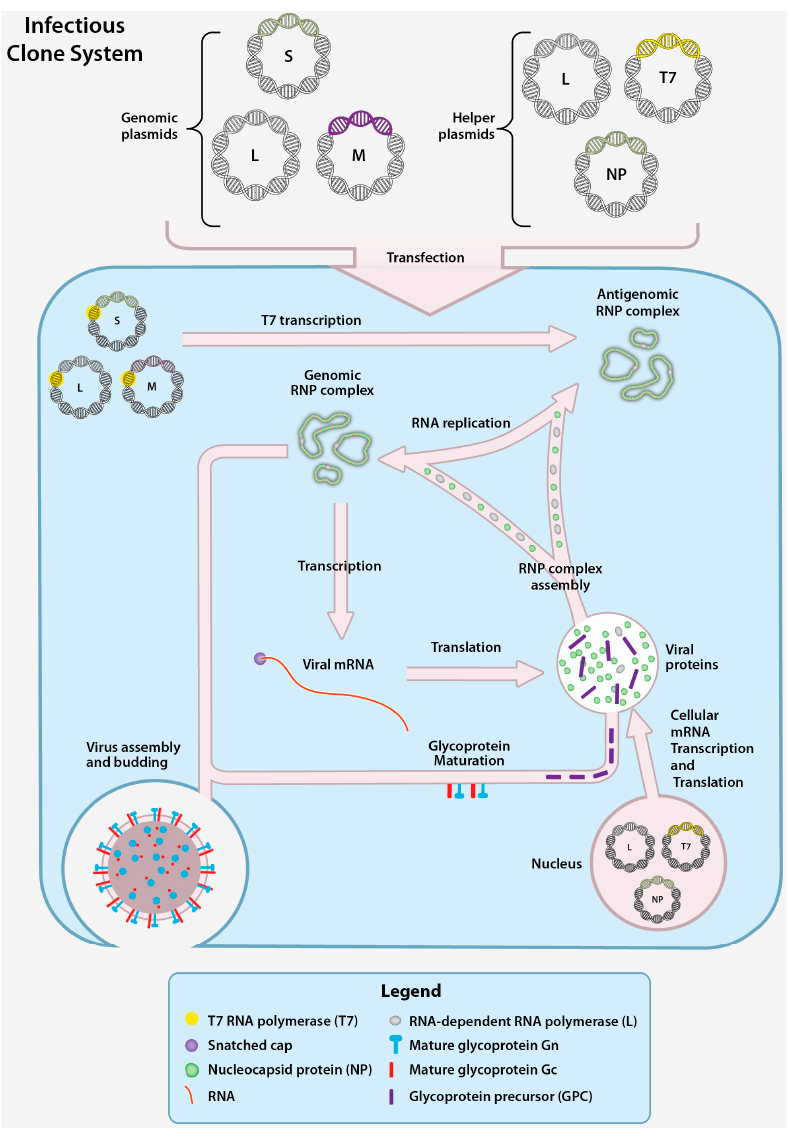
Figure 7. CCHFV infectious clone system. The CCHFV infectious clone system functions by co ‐ transfection of genomic plasmids and helper plasmids into cells. The genomic plasmids each contain the DNA sequence of one of the CCHFV segments (S, M, or L) in the positive sense orientation downstream of a T7 promoter. The three helper plasmids encode the T7 RNA polymerase, the CCHFV NP and the L genes downstream of cellular RNA polymerase II promoters. Following T7 transcription of the genomic plasmid (enabled by the T7 helper plasmid), the cRNA is encapsidated by NP and L protein to form the antigenomic RNP, and is subsequently replicated by helper plasmid ‐ derived NP and L protein. The vRNAs from the genomic RNPs are transcribed to mRNA and translated to yield CCHFV mRNA. The CCHFV mRNA are translated into additional NP, L, and GPC. The GPC undergoes processing and to yield the mature Gn and Gc. Following the accumulation of genomic RNPs and mature glycoproteins, infectious CCHFV particles assemble and are released.